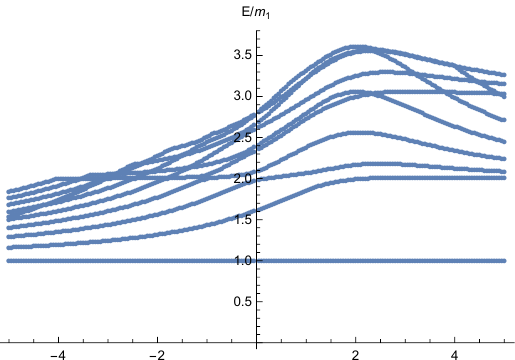
Figure 4. Level 19 result for energy levels as a function of η . The cylinder circumference is taken to be 2 πR = 6 η/m f , where m f is the free fermion mass. Here we have subtracted the ground state energy and normalized the energy levels with respect to the mass m 1 of the lightest particle. The parts of the curves for E/m 1 between 1 and 2 correspond to stable particles, whereas those with E/m 1 > 2 represent scattering states of two or more